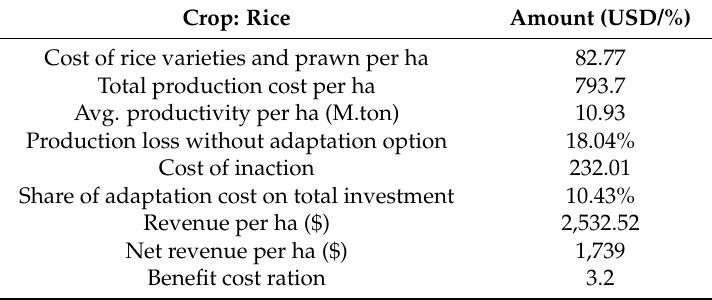
Table 5. Economic analysis of rice-prawn